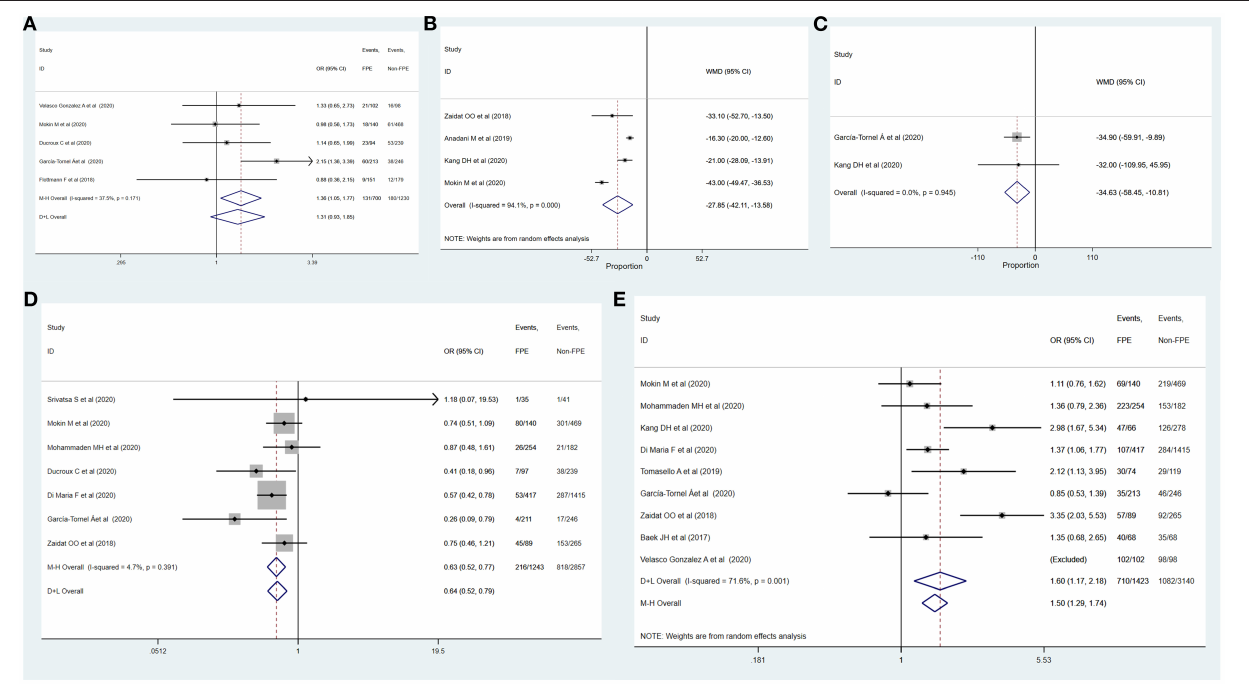
FIGURE 3 | Determinants of achieving successful recanalization with FPE. (A) M2; (B) duration of intervention; (C) time of onset to recanalization; (D) general anesthesia; (E) use of BGC.